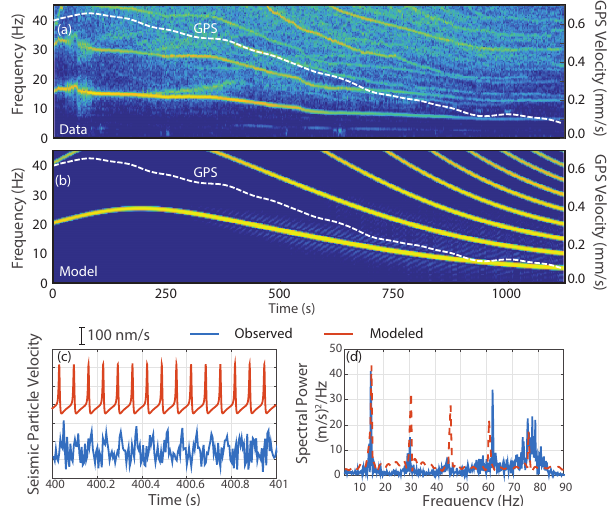
Figure 3. Comparison between observed (a) and modeled (b) tremor episode spectrograms for the episode that occurred on 14 January 2011 at 11:31. The white dashed line is the observed GPS velocity. The logarithmic color scales in both spectrograms are the same and have units of power spectral amplitude (ms − 1 ) 2 / Hz. The data were high-pass filtered above 1Hz before creating the spec- trograms. The spectrograms use an 800 sample window with 50% overlap. We compare the modeled (red) and observed (blue) seismic velocity trace in (c) and frequency spectrum in (d) . The frequency spectrum in (d) is calculated over four second time windows for both the data and the model. Spectral bands from other, lower am- plitude tremor sources are also present in the data shown in (a) .